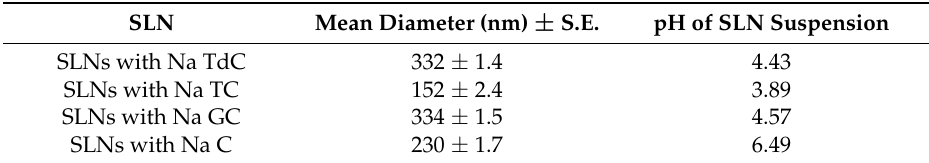
Table 4. Mean diameter (nm) ± standard error and pH of empty SLN suspensions in Pluronic ®